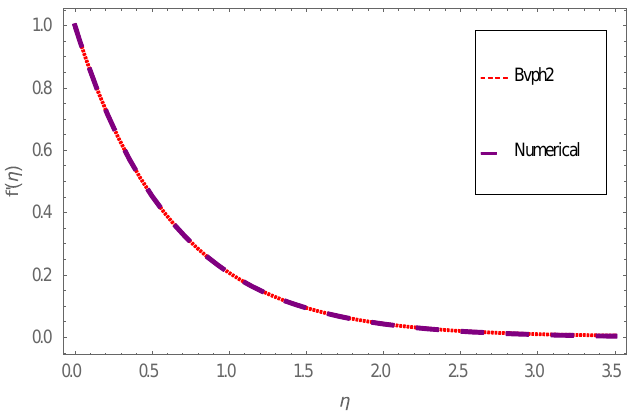
Figure 15. Velocity comparison.